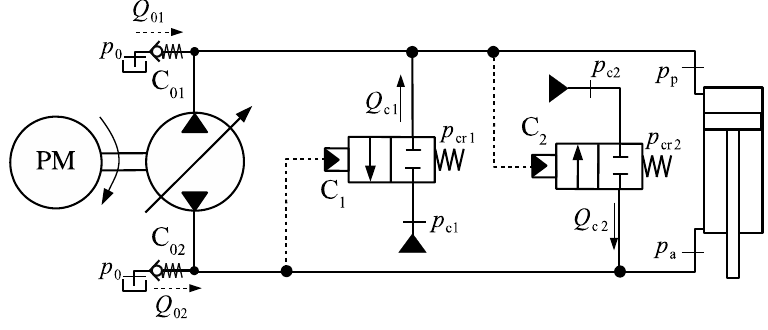
Figure 17. Circuit with two directional valves.